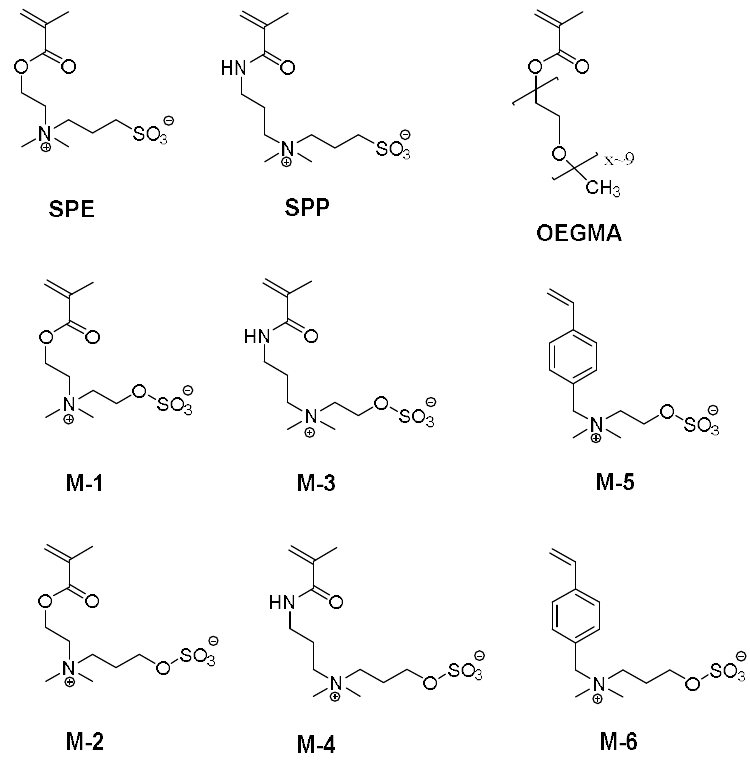
Figure 1. Chemical structures of the zwitterionic sulfobetaine ( SPE , SPP )- and sulfabetaine monomers ( M-1 to M-6 ) used, and of the reference monomer OEGMA .